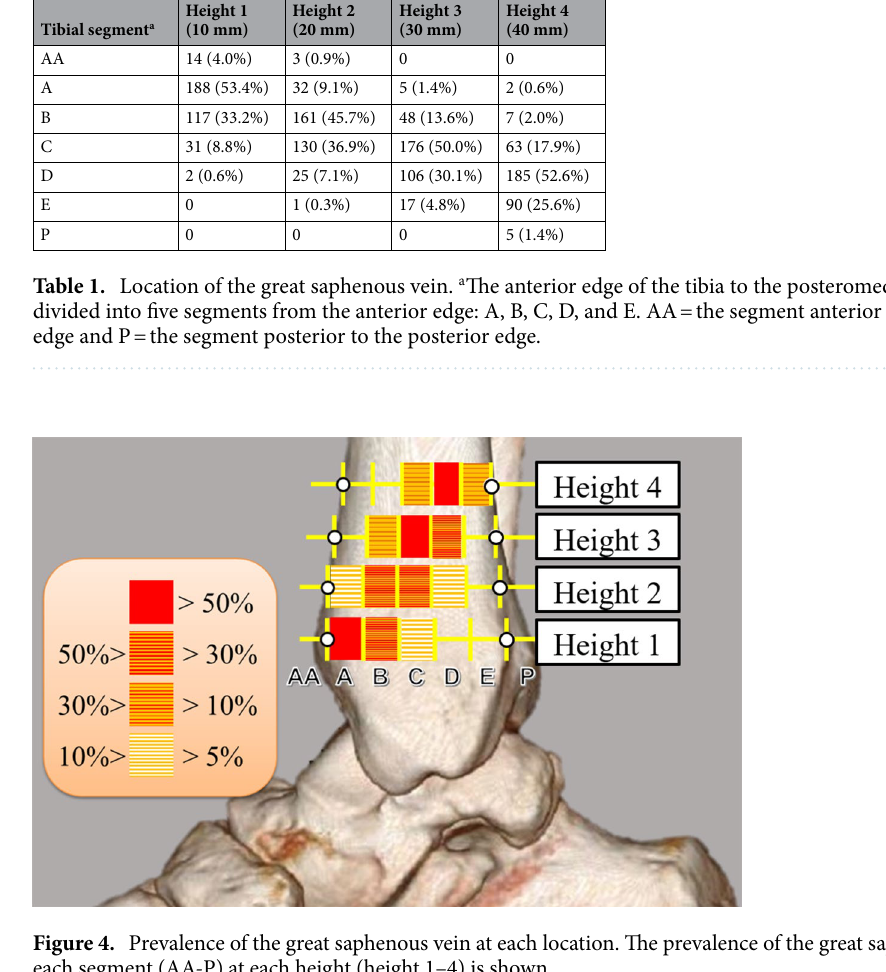
Tibial segment a